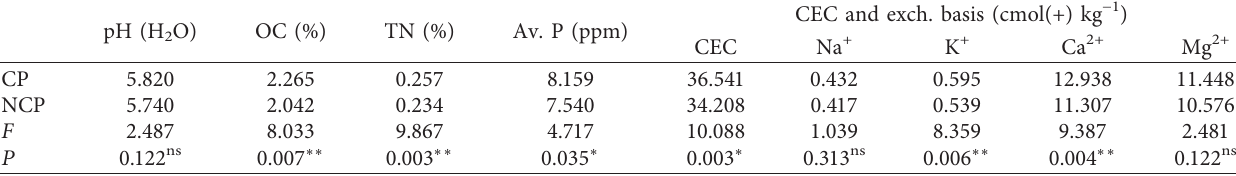
Table 2: The significance test of mean differences of soil chemical properties between conserved and nonconserved plots. pH (H 2